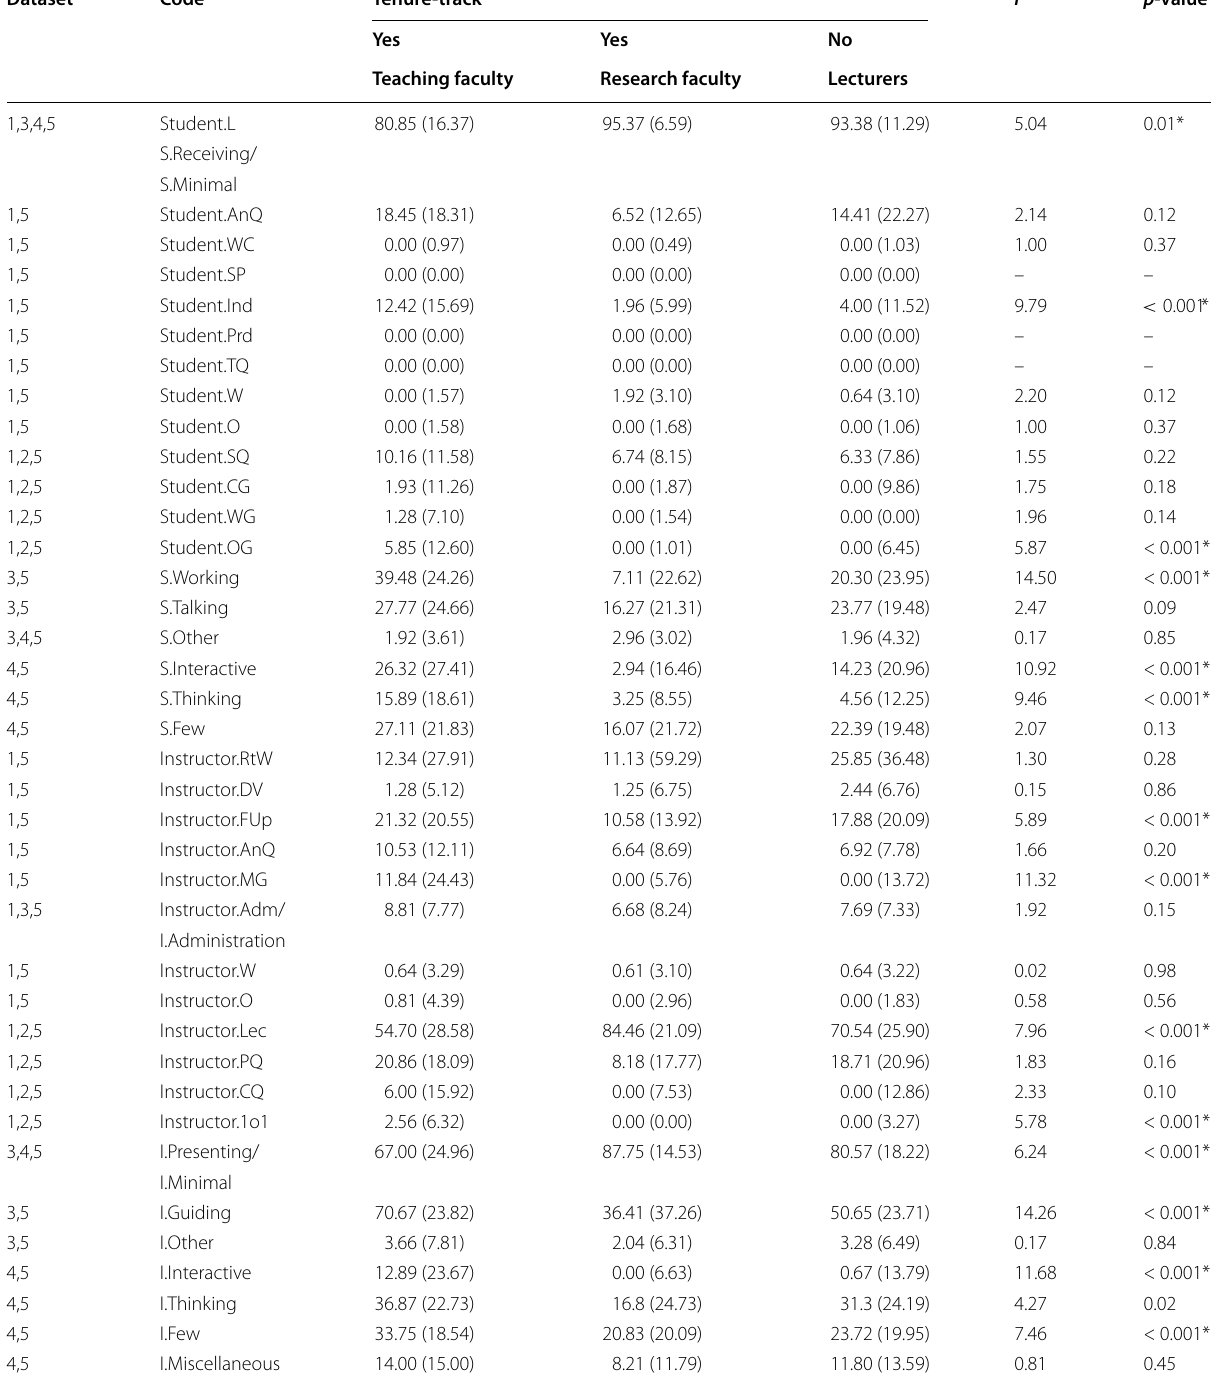
Mean and standard deviation (in parentheses) are given as well as the F statistic and p -value for testing if there is a difference in the amount of time spent on a code across the three faculty types. Significance is denoted for codes using a Bonferroni correction of α ∗ = 0.05 / 38 =